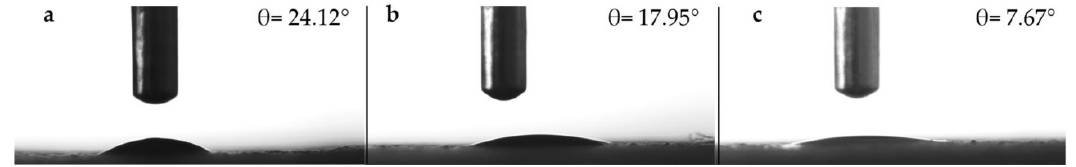
Figure 12. Contact angle reduction for a traverse speed of 7000 mm/min and: ( a ) 0.1 mm; ( b ) 0.3 mm; ( c ) 0.45 mm.